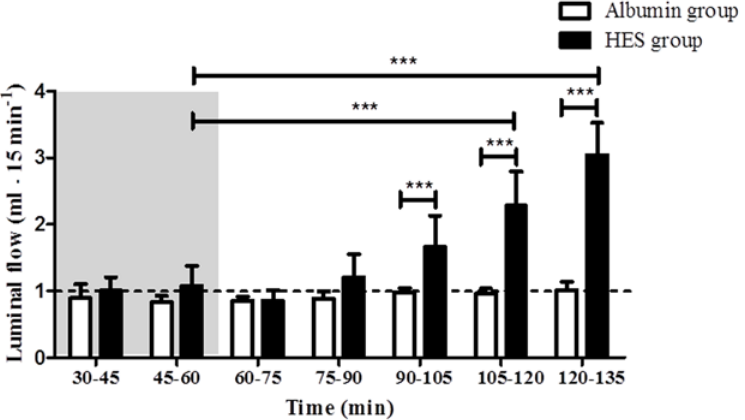
Fig 3. Luminal flow. Luminal effluent flow was measured in 15 minutes intervals. Areas shaded in grey indicate the equilibration phase. The default luminal flow rate is represented by a dashed line. Error bars denote the mean ± SD. Albumin (N = 7), HES (N = 7). *** , p < 0.001.